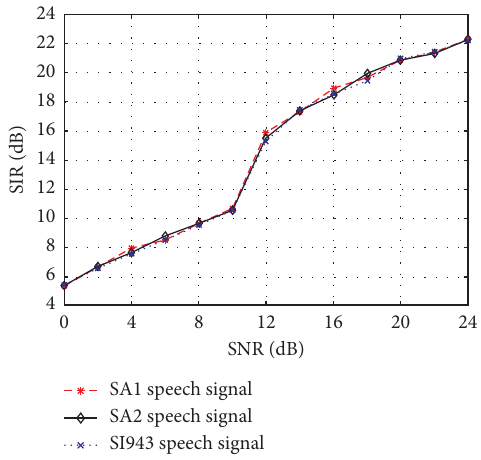
Figure 20: SIR of speech